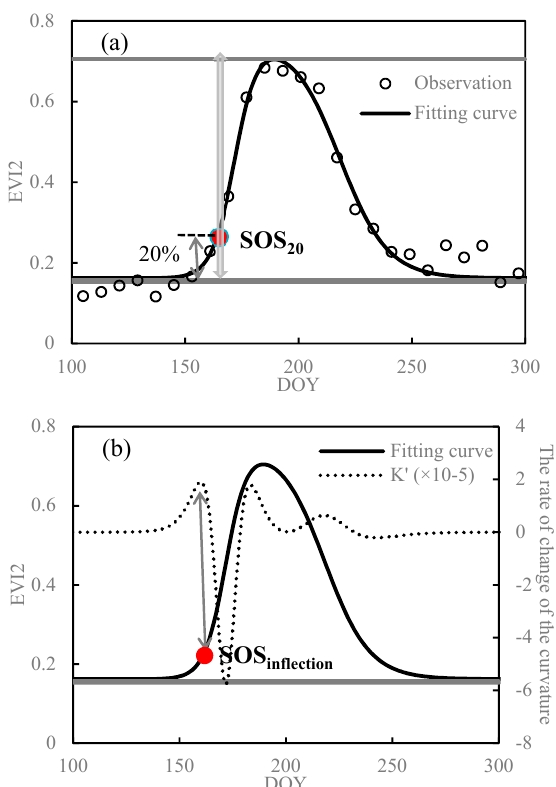
Figure A1. An example showing the extraction of SOS 20 and SOS inflection from the fitted curve of EVI2. The K’ is the first-order derivative of the curvature of the fitted EVI2 curve (Equation (3)).